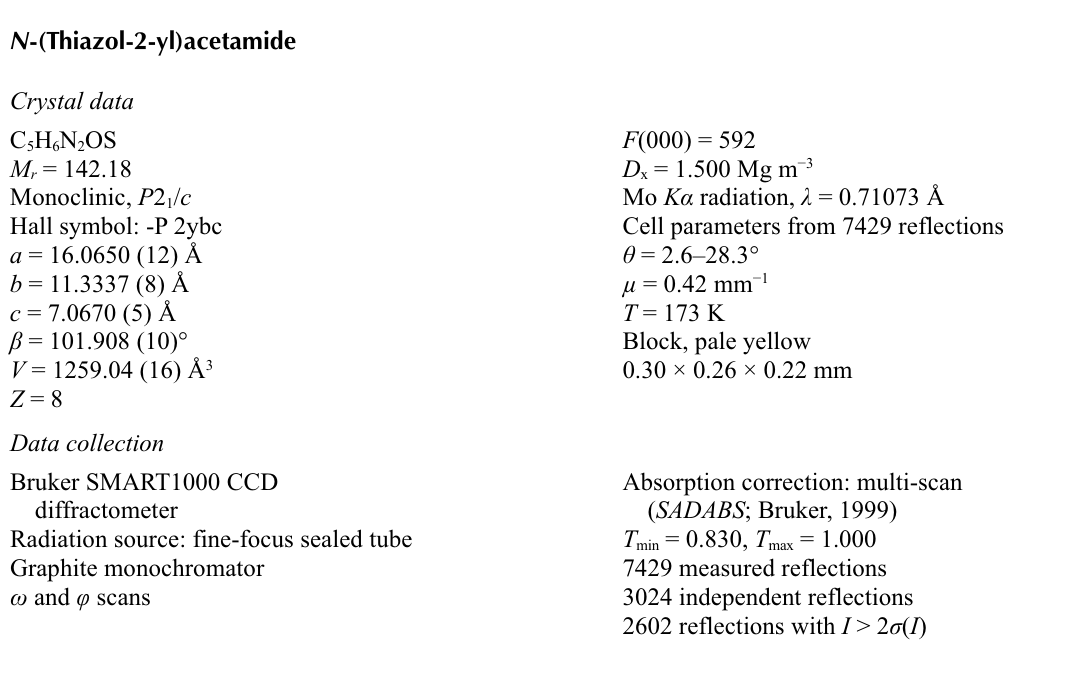
Figure 2 A packing diagram for (I) showing N—H···N hydrogen